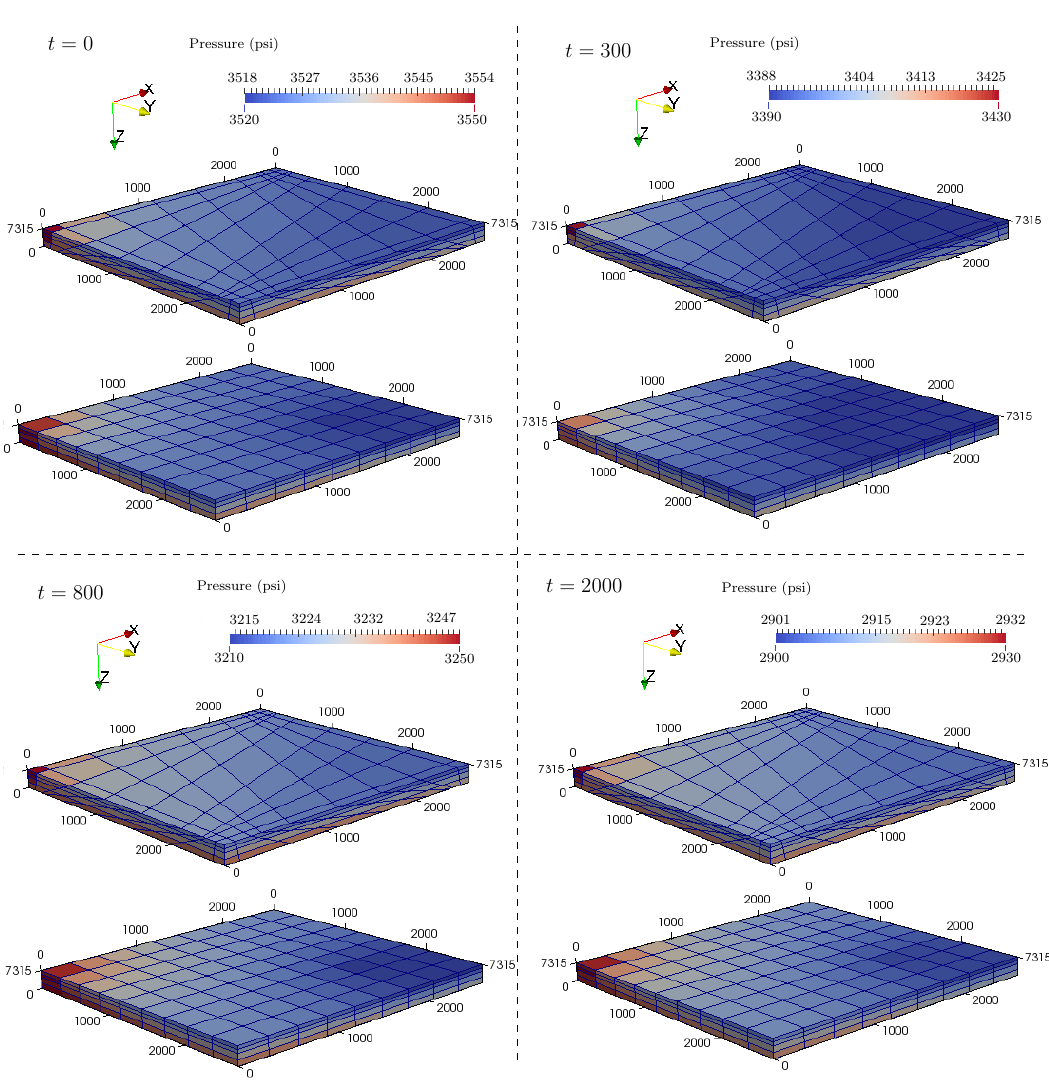
Figure 7. Pressure variation at different time steps in both, orthogonal an non-orthogonal grid (fully corrected). The oil produced in this reservoir is governed by condensation of intermediate com- ponents from the gas phase once it reaches the surface and oil mobilization once the critical saturation is reached. Notice that the most significant variable in reservoir simulation is the oil rate computed at the surface. Figure 8 shows surface oil production for the different test geometries. The obtained results validate the implemented formulation in FlowTraM and show the improvement in convergence obtained by introducing the proposed first and second-order corrective